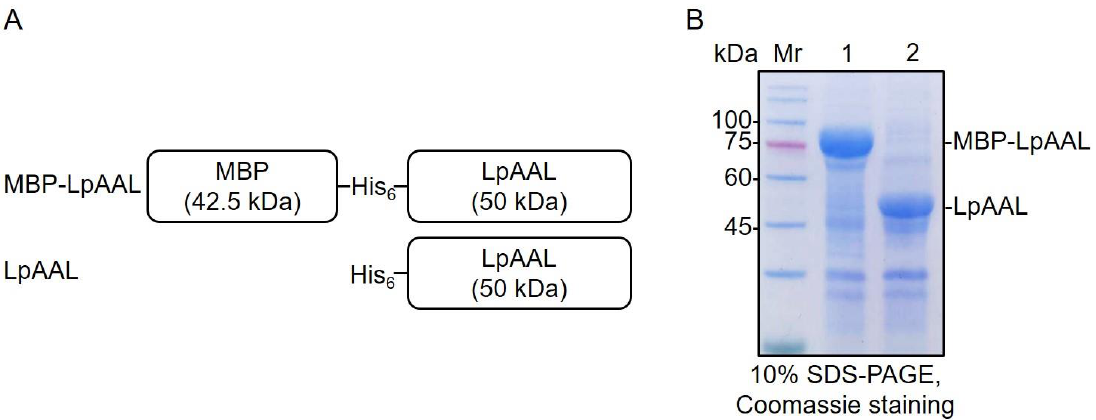
Figure 2. Preparation of recombinant MBP-LpAAL and LpAAL proteins. ( A ) LpAAL protein and MBP-LpAAL fusion protein were expressed in Escherichia coli . ( B ) Recombinant proteins were purified using Ni-NTA affinity column and separated using 10% SDS–PAGE, and then stained with Coomassie Blue dye. Mr, molecular weight SDS–PAGE marker; lane 1, MBP-LpAAL; lane 2, LpAAL. MBP: maltose-binding protein .